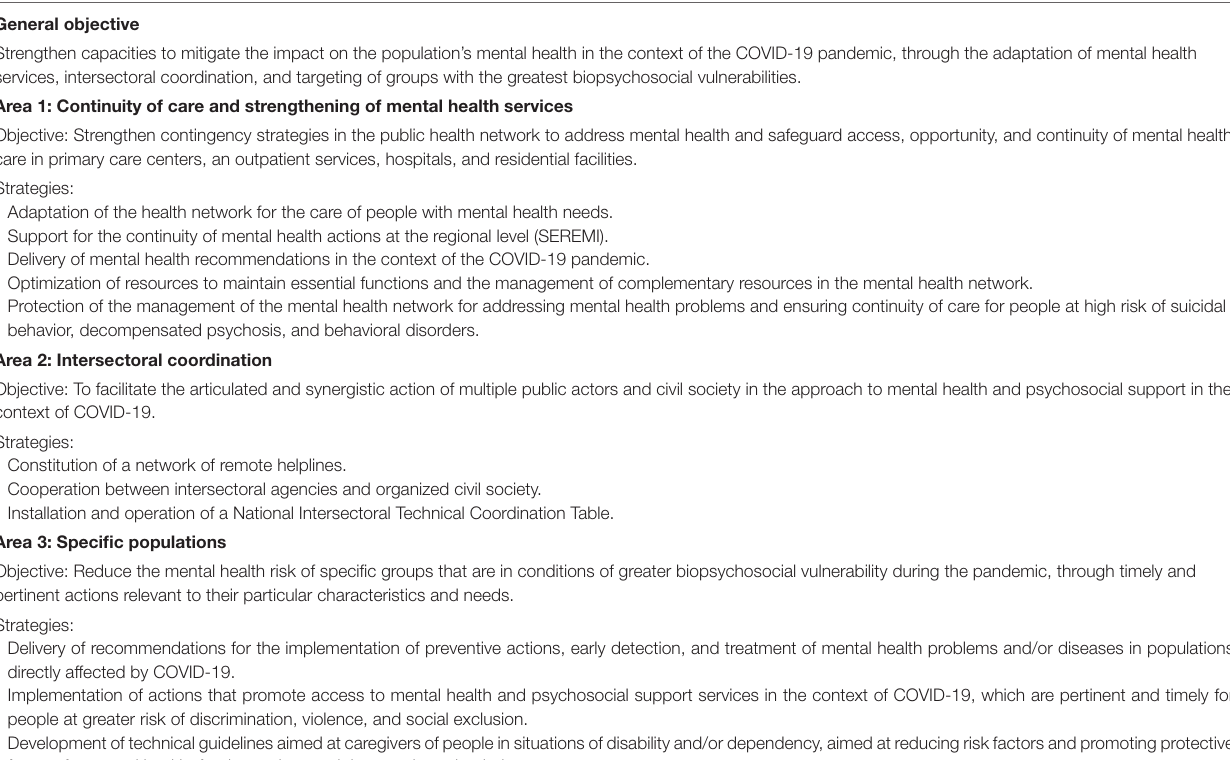
TABLE 1 | COVID-19 Mental Health Action Plan: areas of action, objectives, and strategies. General